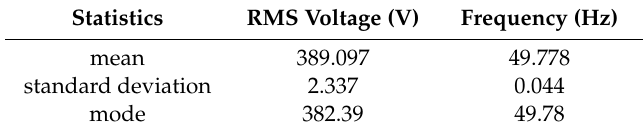
Figure 1. Exemplary voltage and frequency deviations on a ro-ro ship over changing of power plant configuration [3]. Table 1. The statistical properties of rms voltage and frequency in the network of a ferry [4].